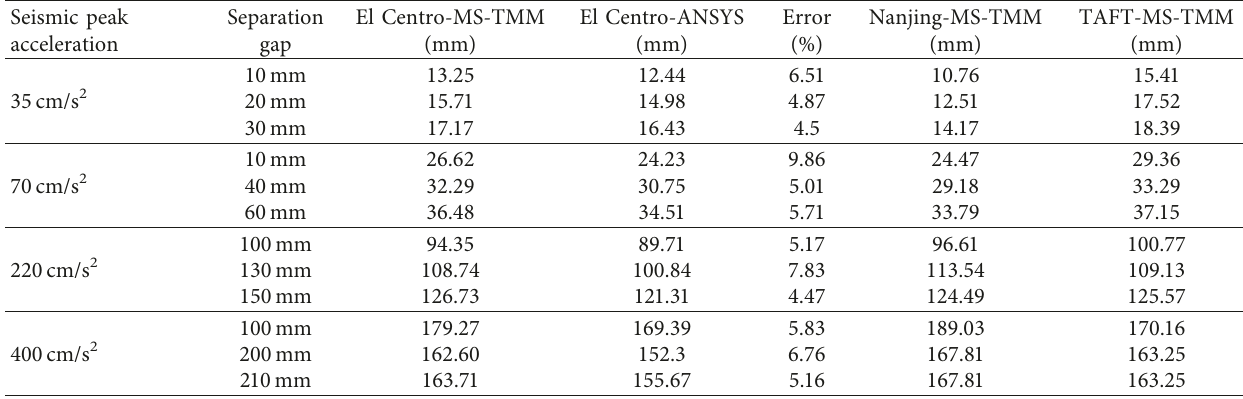
a 2 , 310 displacement under seismic wave (peak acceleration is 400cm/s Table 4: Peak displacement of J